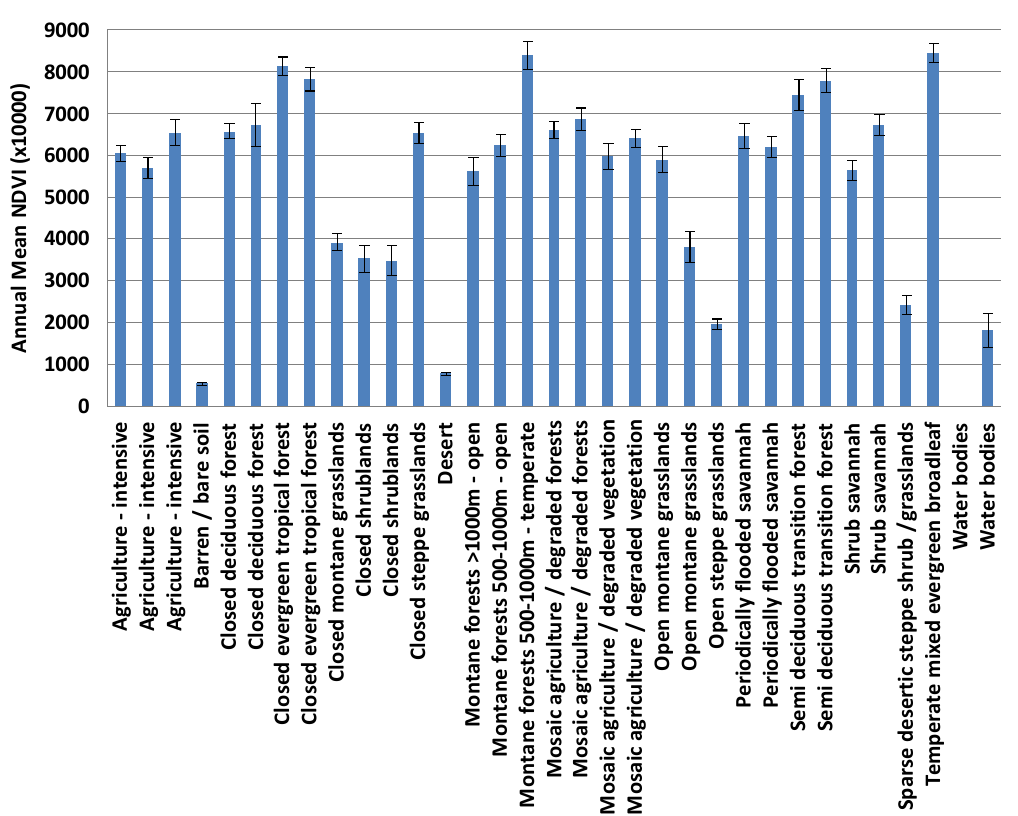
Figure 4. Thirty-year mean annual NDVI and ±STD for representative vegetation cover types samples (see Figure 1).